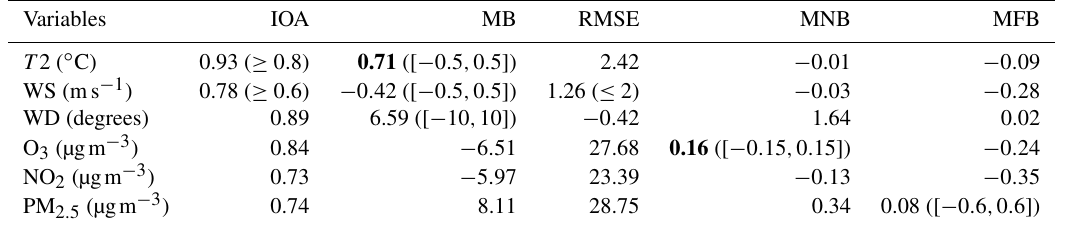
Table 2. Mean model performance metrics for meteorological factors and air pollutants. The values that do not meet the benchmarks are denoted in bold.